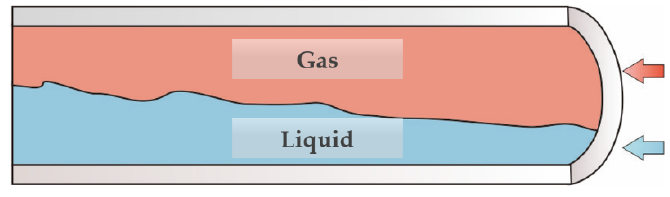
Figure A1. Schematic of multiphase flow in a pipe.